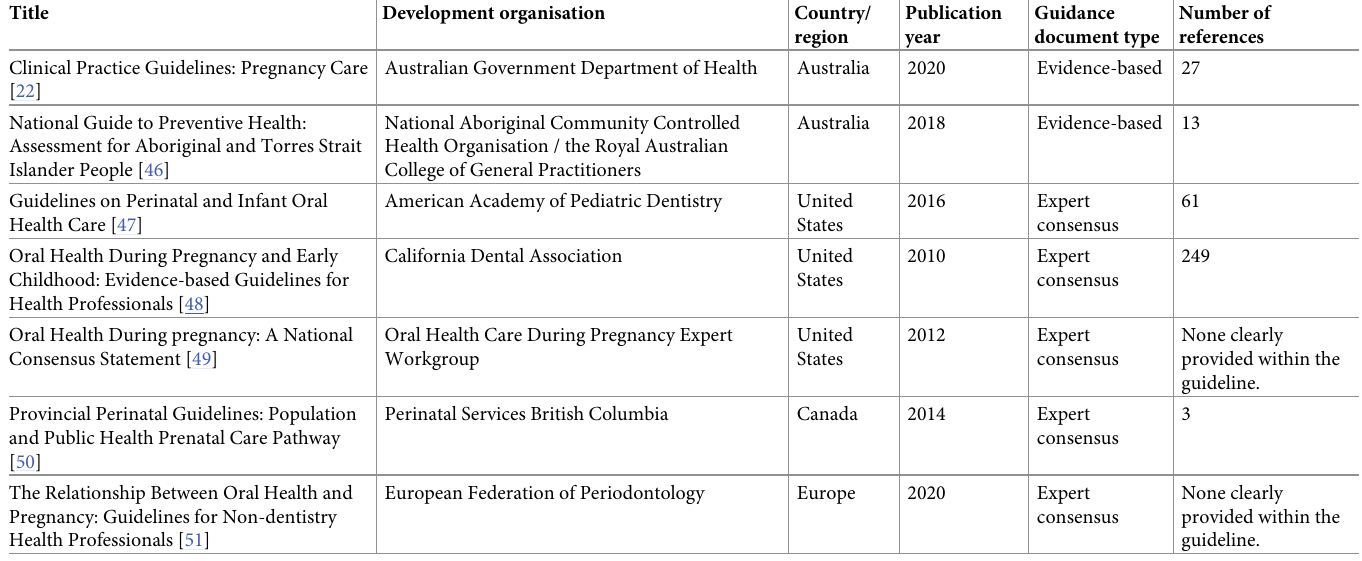
Table 1. Summary characteristics of included guidance